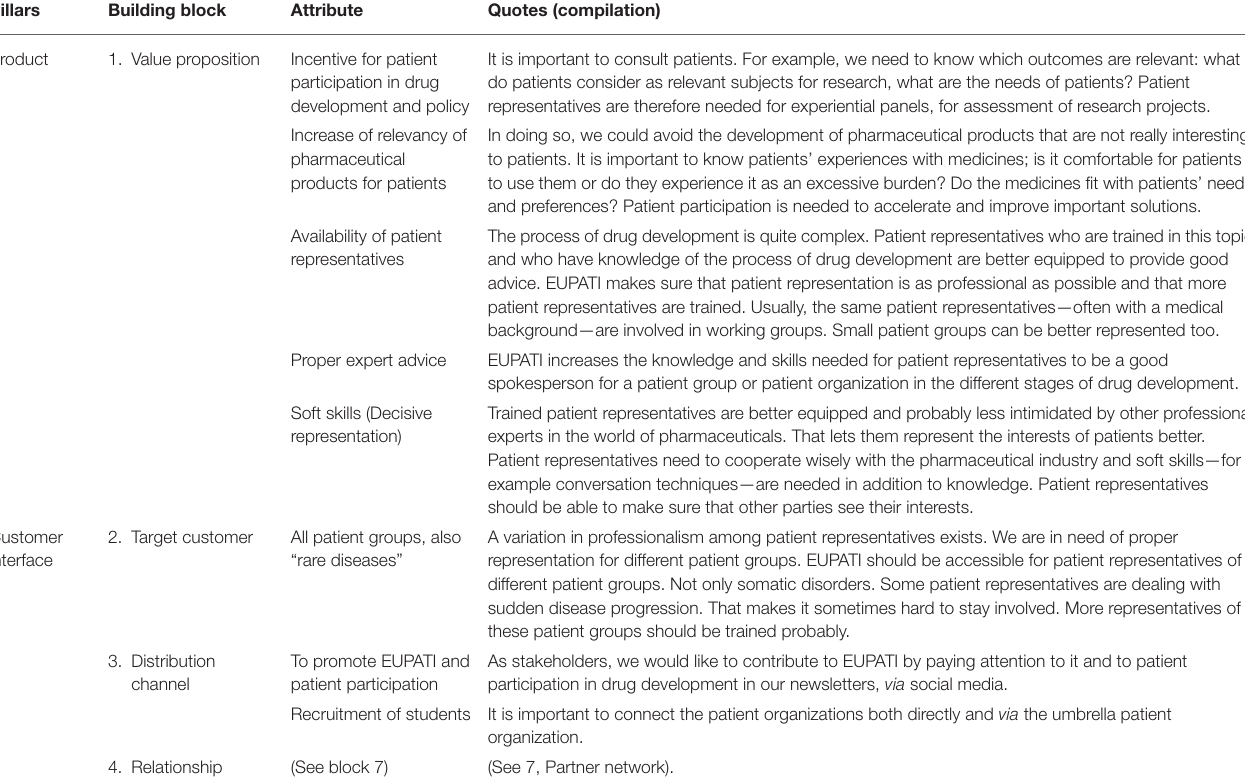
TABLE 2 | Product and customer interface of the Dutch EUPATI course according to stakeholders.